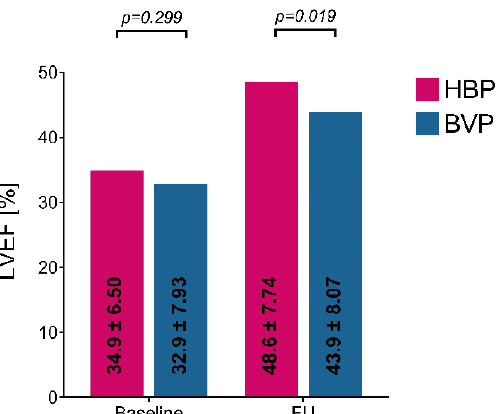
Figure 3. Left ventricular ejection fraction at baseline and follow-up in HBP and BVP patients. LVEF—left ventricular ejection fraction, HBP—His bundle pacing, BVP—biventricular pacing, FU— LVEF — left ventricular ejection fraction, HBP — His bundle pacing, BVP — biventricular pacing, FU — follow-up.